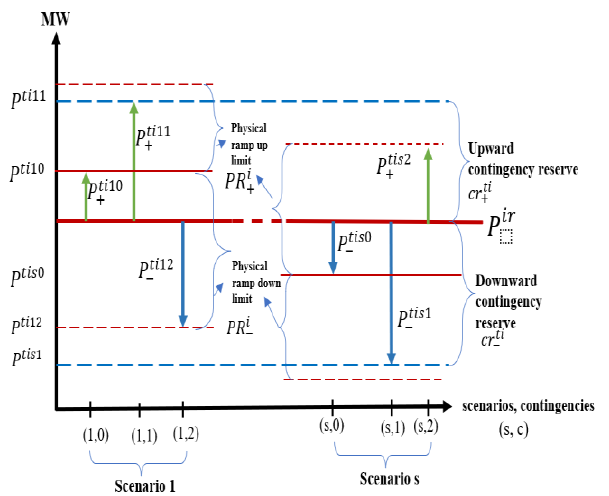
Figure 6. Reserve structure for generator i , for several contingencies c , in presence of uncertainty scenarios s .